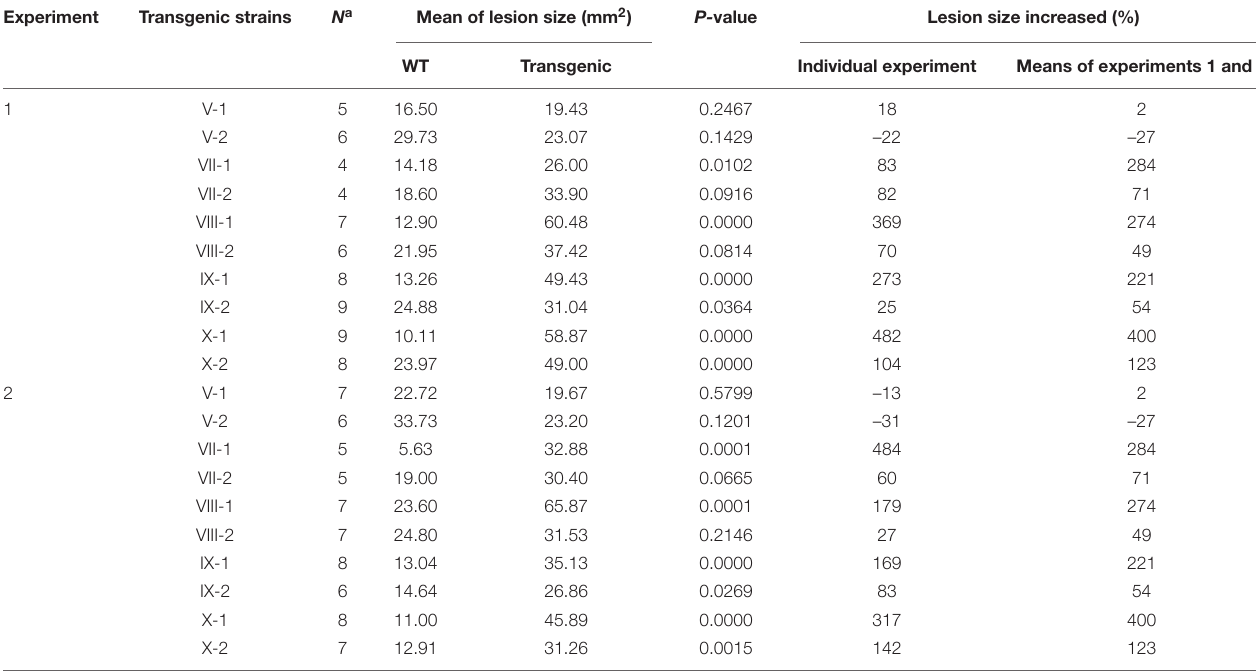
a N indicates the numbers of fruits used in each